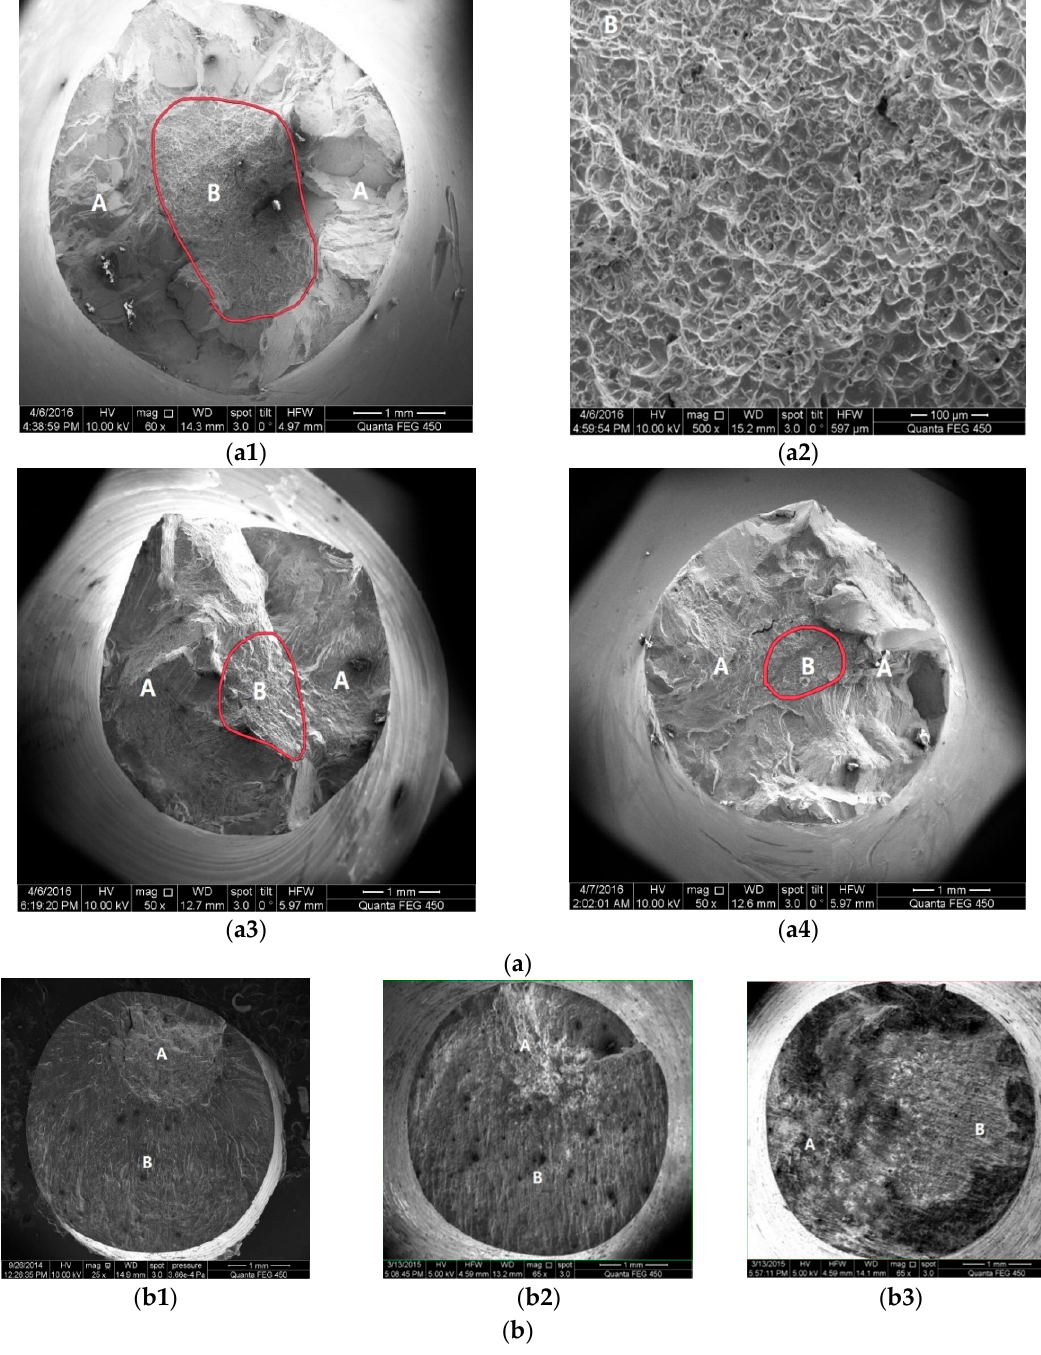
Figure 7. Scanning electron microscopy (SEM) fracture morphologies for AA6063 ‐ T4 and AA7475 ‐ T7351 in the different media. ( a ) AA6063 ‐ T4; ( a1 ) in the air case; ( a2 ) in the air case; ( a3 ) at 3.5% NaCl solution; ( a4 ) at 5.0% NaCl solution; ( b ) AA7475 ‐ T7351; ( b1 ) in the air case; ( b2 ) at 3.5% NaCl solution; ( b3 ) at 5.0% NaCl solution.